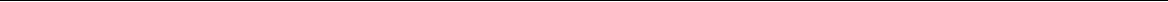
Fig. 3 The novel RhoA regulatory network of MAGI2, TNS2, DLC1, CDK20, and CAV1 is a central part of the pTSNS pathogenesis. a Overexpression of GFP-tagged MAGI2 wild type (WT) but not the two MAGI2 mutants from pTSNS patients resulted in a signi fi cant increase in active RhoA. Active RhoA was measured by G-LISA assay in HEK293T cells. b Myc-tagged TNS2 -WT increased active RhoA levels upon overexpression in HEK293T cells as compared to Mock. However, all six TNS2 mutant clones from pTSNS patients failed to increase active RhoA. c GFP-tagged CDK20 -WT showed a signi fi cant increase in active RhoA level upon overexpression in HEK293T cells, while the mutant clone Phe240Leu, from a pTSNS patient, failed to do so. d Myc-tagged DLC1 -WT showed a signi fi cant decrease in active RhoA level upon overexpression in HEK293T cells as compared to Mock. However, none of the six DLC1 mutant clones from pTSNS patients showed this effect. e siRNA mediated knockdown of MAGI2 decreased active RhoA. The overexpression of Magi2-WT rescued this effect while both the mutants from pTSNS patients did not. f siRNA mediated knockdown of TNS2 decreased active RhoA. The overexpression of TNS2-WT rescued this effect, while four out of six TNS2 mutant clones from pTSNS patients did not. g siRNA mediated knockdown of CDK20 decreased active RhoA. This effect was rescued by the overexpression of CDK20-WT, but not by the overexpression of mutant clone Phe240Leu. h